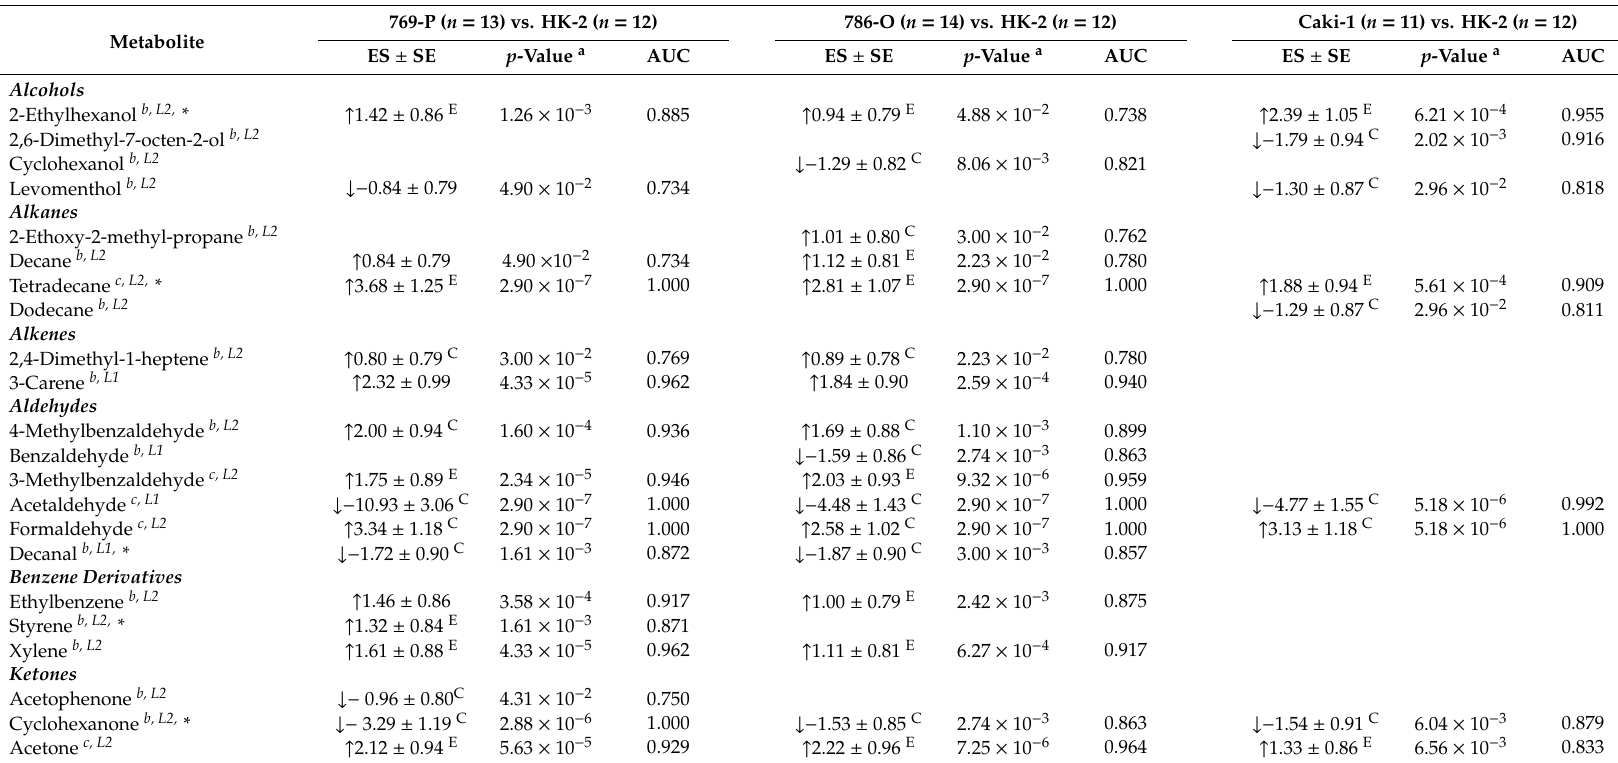
Table 1. List of volatile compounds (VOCs and VCCs) significantly altered between each clear cell renal cell carcinoma (ccRCC; 769-P, 786-O and Caki-1) cell line and the non-tumoral cell line